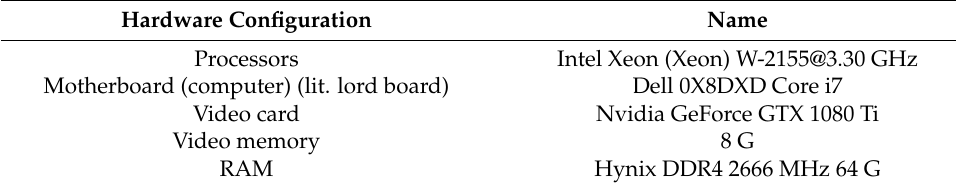
Table 4. Hardware platform configuration